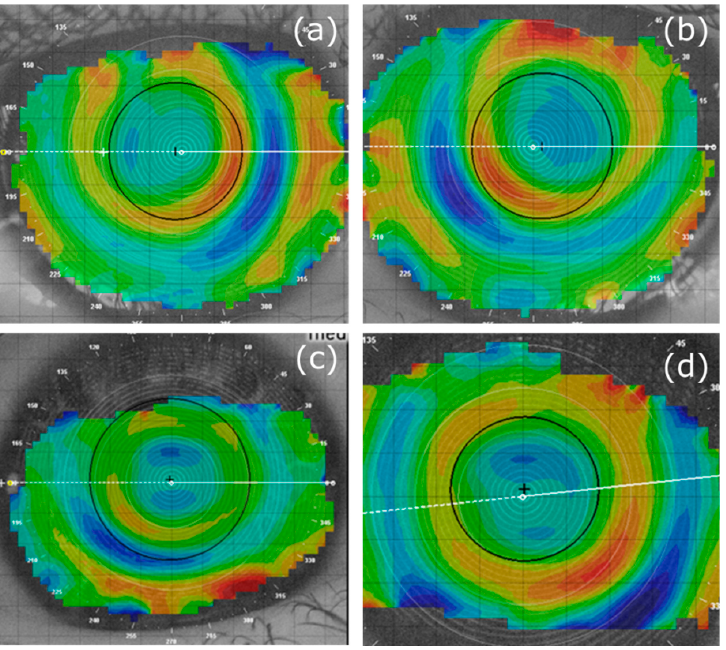
Figure A2. Tangential difference maps (18-month topography minus baseline topography). ( a ) Map for the MOK-treated eye with the greatest axial length increase over 18 months (+0.34 mm) and ( b ) map for the fellow OK-treated eye with an AL increase of +0.17 mm. ( c ) MOK-treated eye with the least axial length increase over 18 months ( − 0.48 mm) and ( d ) map for the fellow OK-treated eye with an AL increase of − 0.27 mm.